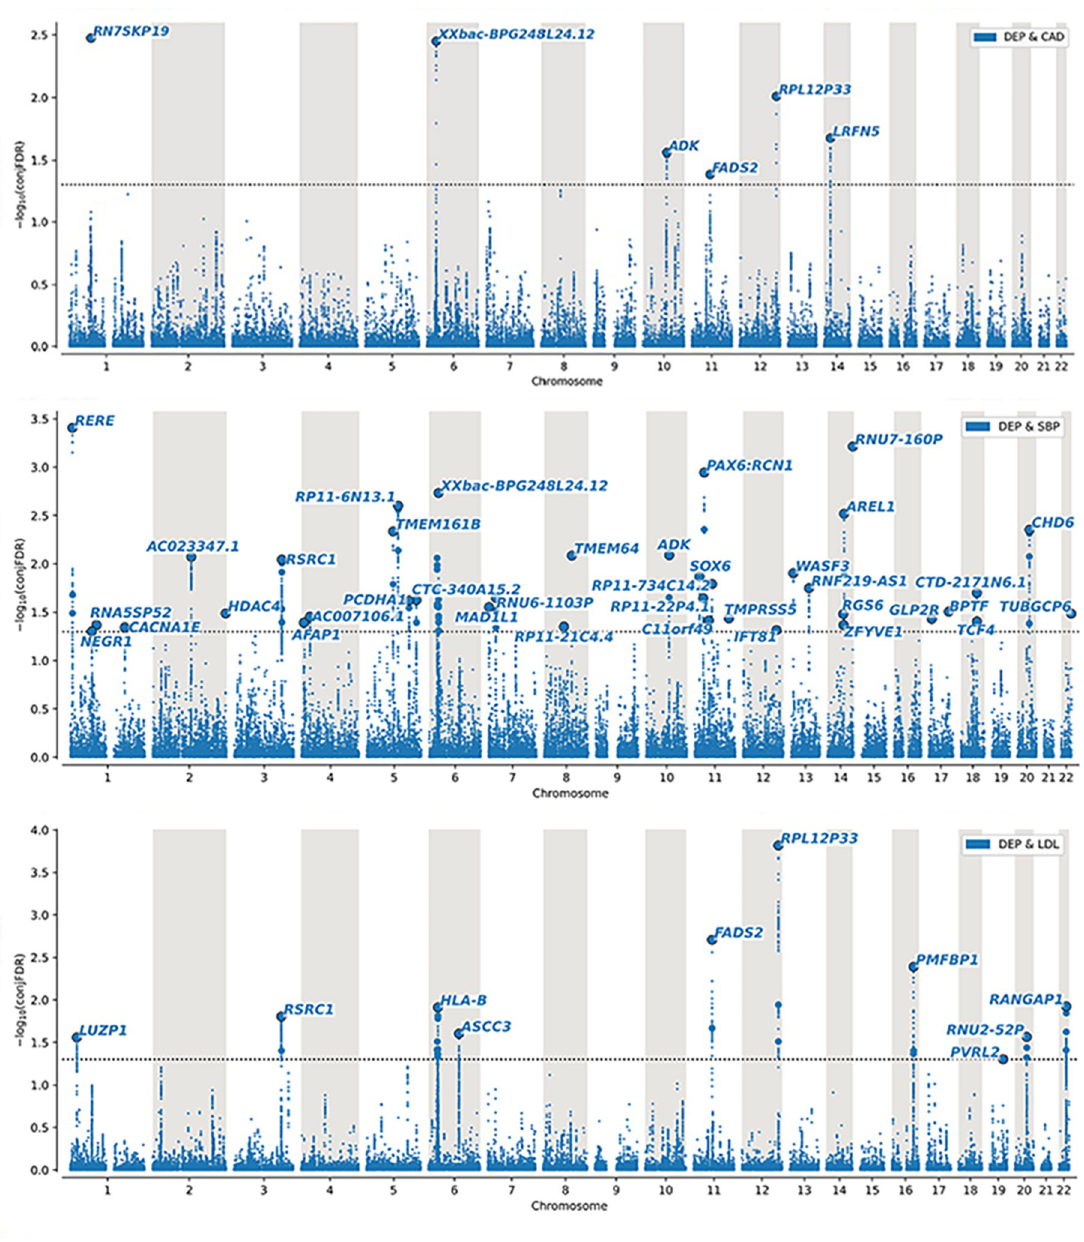
Fig 2. ConjFDR Manhattan plot. Common genetic variants both associated with depression (n = 450,619) and a) CAD (n = 502,713), b) SBP (n = 750,000) and c) LDL (n = 297,626) at conjunctional false discovery rate (conjFDR) < 0.05. Manhattan plot showing the– log10 transformed conjFDR values for each SNP on the y axis and the chromosomal positions along the x axis. The dotted horizontal line represents the threshold for significant shared associations (conjFDR < 0.01, i.e. -log10(conjFDR) > 2.0). Independent lead SNPs are encircled in black, and labeled by its nearest gene. The significant shared signal in the major histocompatility complex region (chr6:25119106–33854733) is represented by one independent lead SNP. Further details are available in S8 Table. Dep; depression, CAD; coronary artery disease, SBP; systolic blood pressure, LDL; low-density lipoprotein.